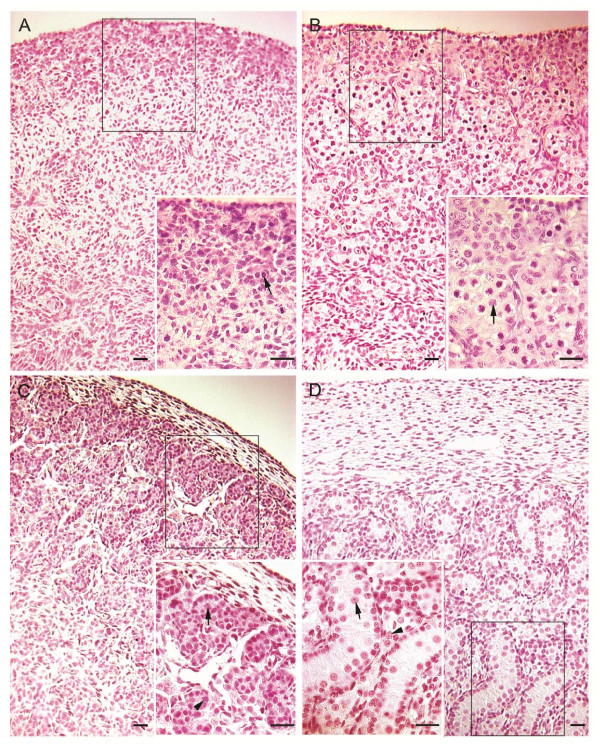
Tissue sections of GD42 and GD75 ovaries and testes stained with hematoxylin and eosin. A) GD42 ovary illustrating a thin ovarian cortex containing oogonia and precursor granulosa cells. Arrow in insert points to an oogonium. B) GD75 ovary illustrating a thickened cortex containing ovigerous cords. Arrow in insert depicts oocyte within an ovigerous cord. C) GD42 testis demonstrating presence of testicular cords containing gonocytes and Sertoli cells. Arrow in insert points to a gonocyte; arrowhead points to a Sertoli cell nucleus. D) GD 75 testis revealing prominent testicular cords. Arrow in insert points to a gonocyte; arrowhead points to an interstitial (Leydig) cell. All bars are 20 μm.